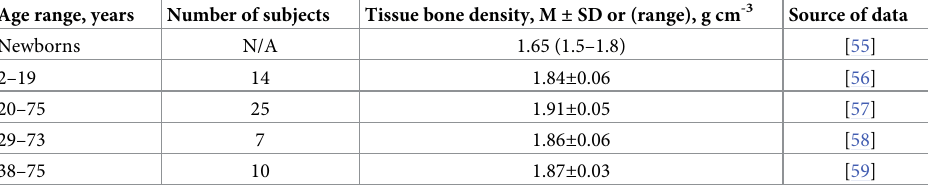
Table 3. Estimates of tissue bone density in different